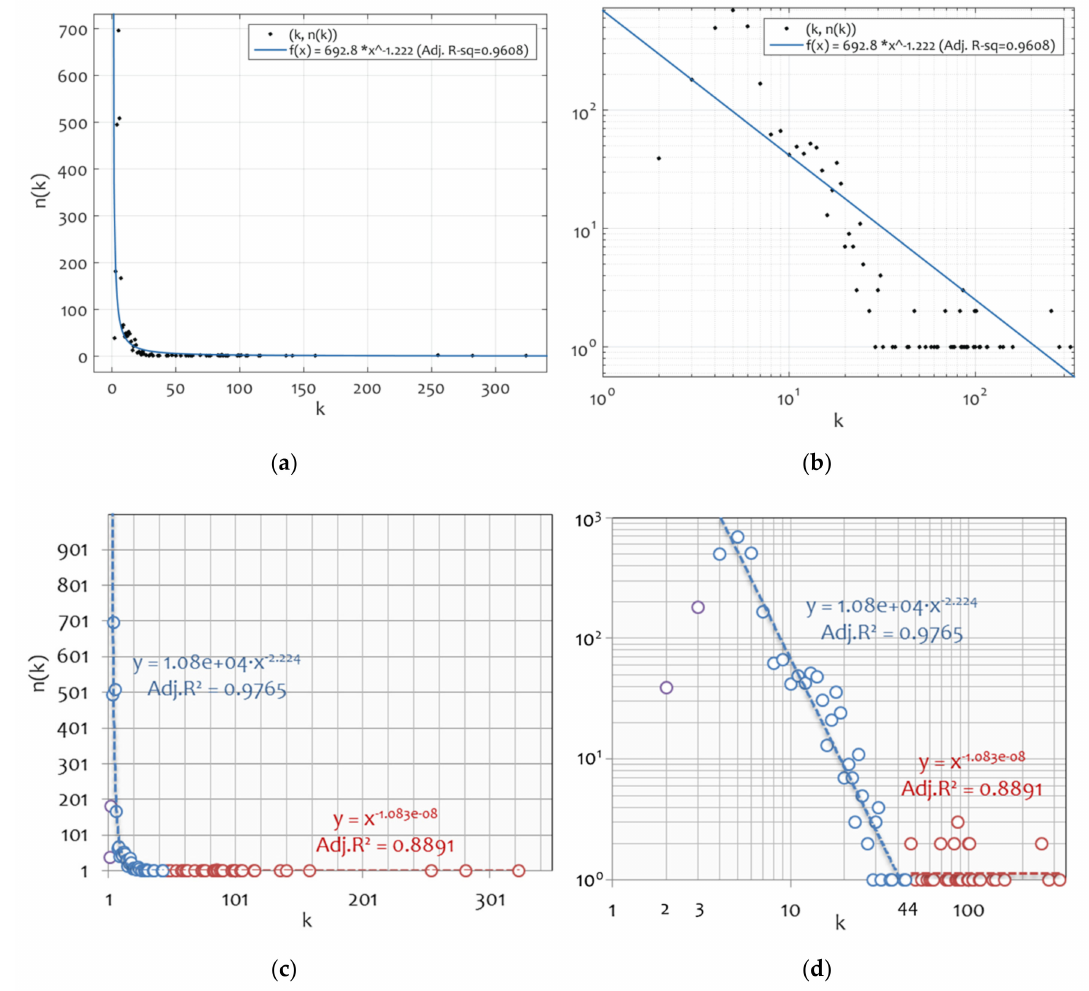
Figure 3. The degree distribution of the visibility graph associated to the available voltage oscillation time-series of TlInTe 2 (see Figure 1), shown at ( a ) metric scale, ( b ) log-log scale, ( c ) metric scale with fitting cut-o ff s at k = 3 and k = 44, and ( d ) log-log scale with fitting cut-o ff s at k = 3. On the other hand, the degree distribution in the region of higher degrees (i.e., k > 44, including 1.53% of the data), which can be considered the hubs’ region, configures a tail that is almost described by a linear and particularly constant pattern (of the form y ≈ x